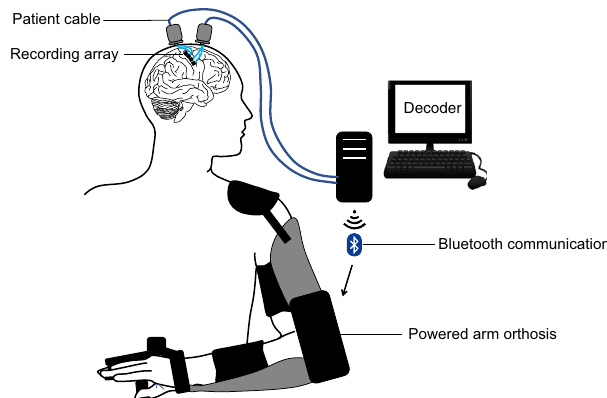
Fig. 2 The cortimo system. The overall device comprises two Multiports, each with two 8 × 8 microelectrode arrays, patient cables linked to external ampli fi ers, a decoding computer and a wearable, powered arm